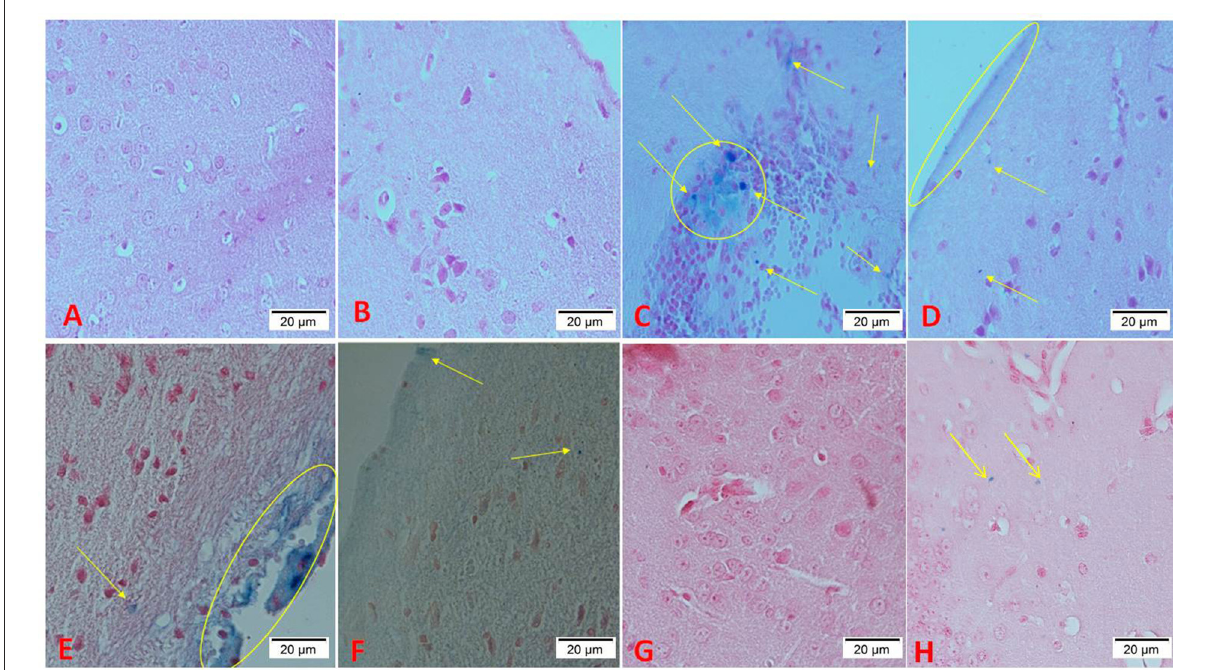
FIGURE4 Perls staining of mice brain tissues [blue spots indicate iron deposition, indicated by arrows and circles; (magnification × 40)]. (A) Control group, normal saline-receiving group; (B) normal saline and DFO-receiving group; (C) iron dextran and normal saline-receiving group; (D) iron dextran and DFO-receiving group; (E) low dose caffeic acid-receiving group (30 mg/kg/day); (F) high dose caffeic acid-receiving group (50 mg/kg/day); (G) low dose ferulic acid-receiving group (30 mg/kg/day); and (H) high dose ferulic acid-receiving group (50